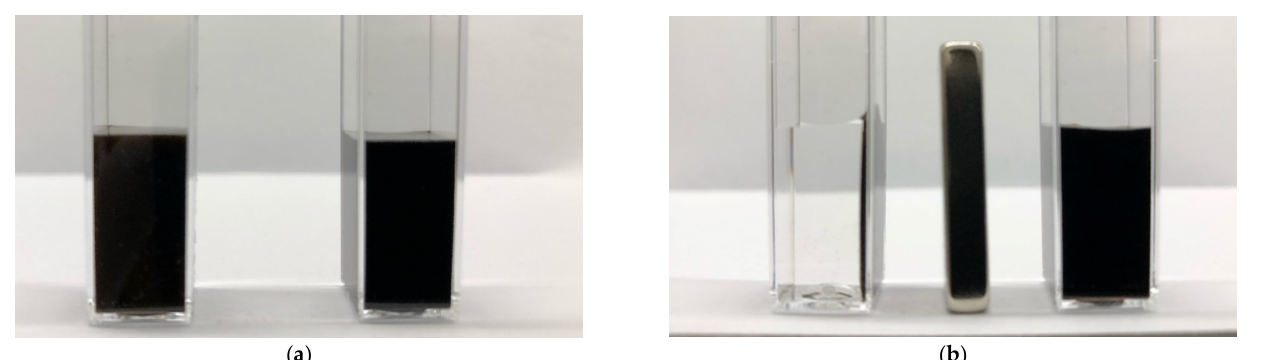
Figure A1. ( a ) Separation of SPION Cit (left) compared to SPION HAp (right) before separation. ( b ) Separation of SPION Cit (left) compared to SPION HAp (right) after 30 sec of magnetic separation.